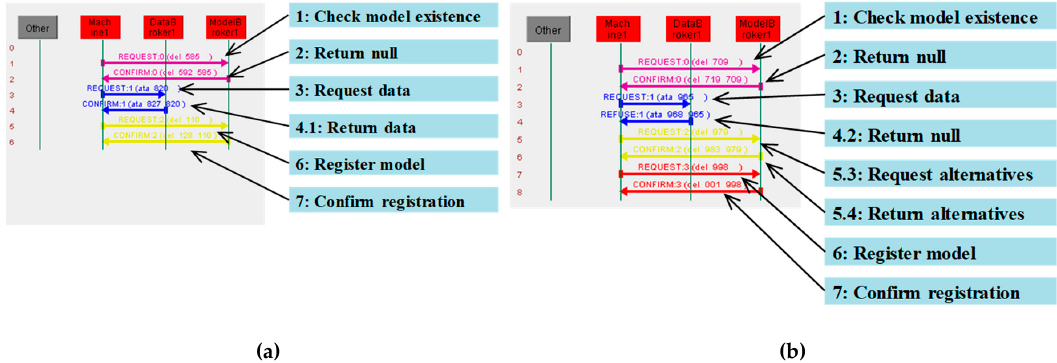
Figure 13. Implementation result: model creation, substitution and registration ( a ) Machine learning- based; ( b ) Transfer learning-based.